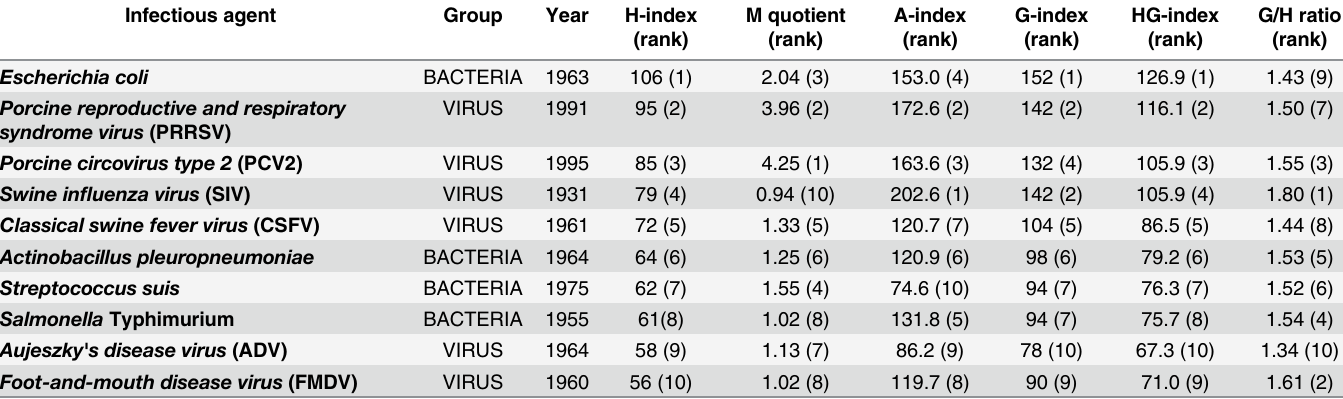
Table 4. Comparison of H-index with other bibliometric indicators for the ten infectious agents with the highest H-indices. Year: year of the oldest publication included in H-index; M quotient: H-index / years from publication of the oldest paper included in H-index; A-index: average number of citations